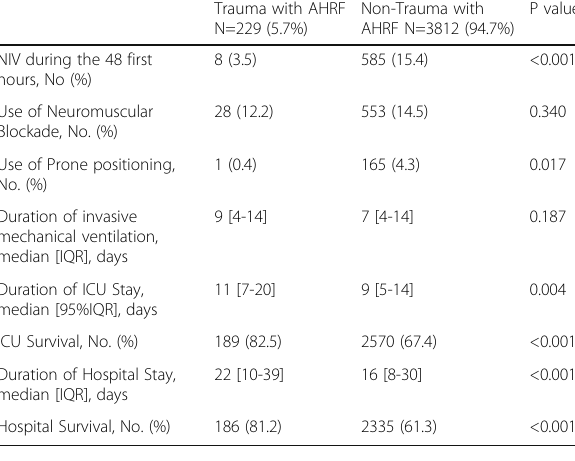
Table 5 (abstract A4). Management and outcome of trauma patients Trauma with AHRF N=229